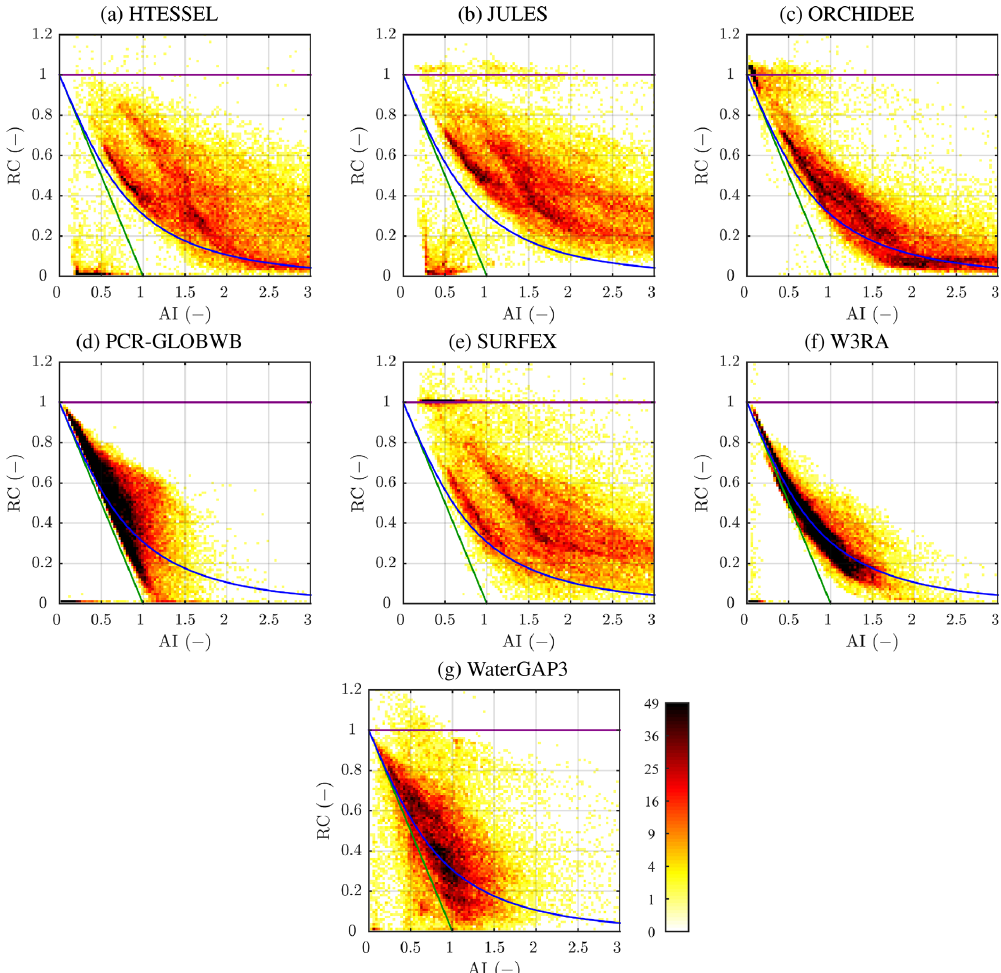
Figure 3. Density plots of grid cell values of aridity index (AI) versus runoff coefficient (RC), for the seven models with data on the available energy. The green line represents the energy limit for which actual evaporation equals PET, the purple line represents the water limit for which runoff equals P , whereas the blue line represents the Budyko (1974)